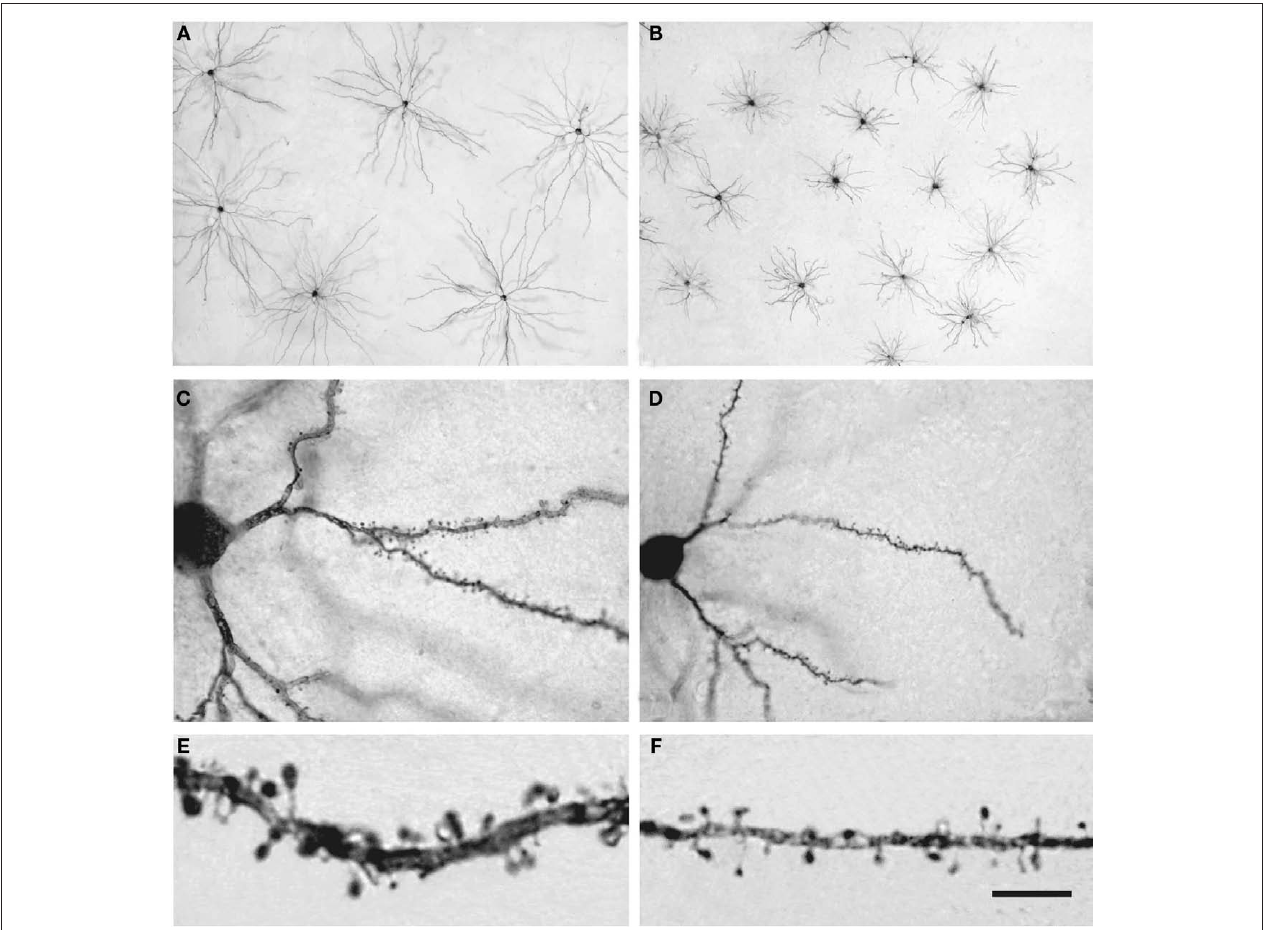
(C) and mouse (D) pyramidal cell. (e,F) : High-power photomicrographs of the basal dendritic segments of human (e) and mouse (F) pyramidal cells illustrating dendritic spines. Note the smaller size of the mouse spines. Scale bar in (F) : 425 μm in (A,B) ; 45 μm in (C,D) ; 10 μm in (e,F) . Taken from Benavides-Piccione et